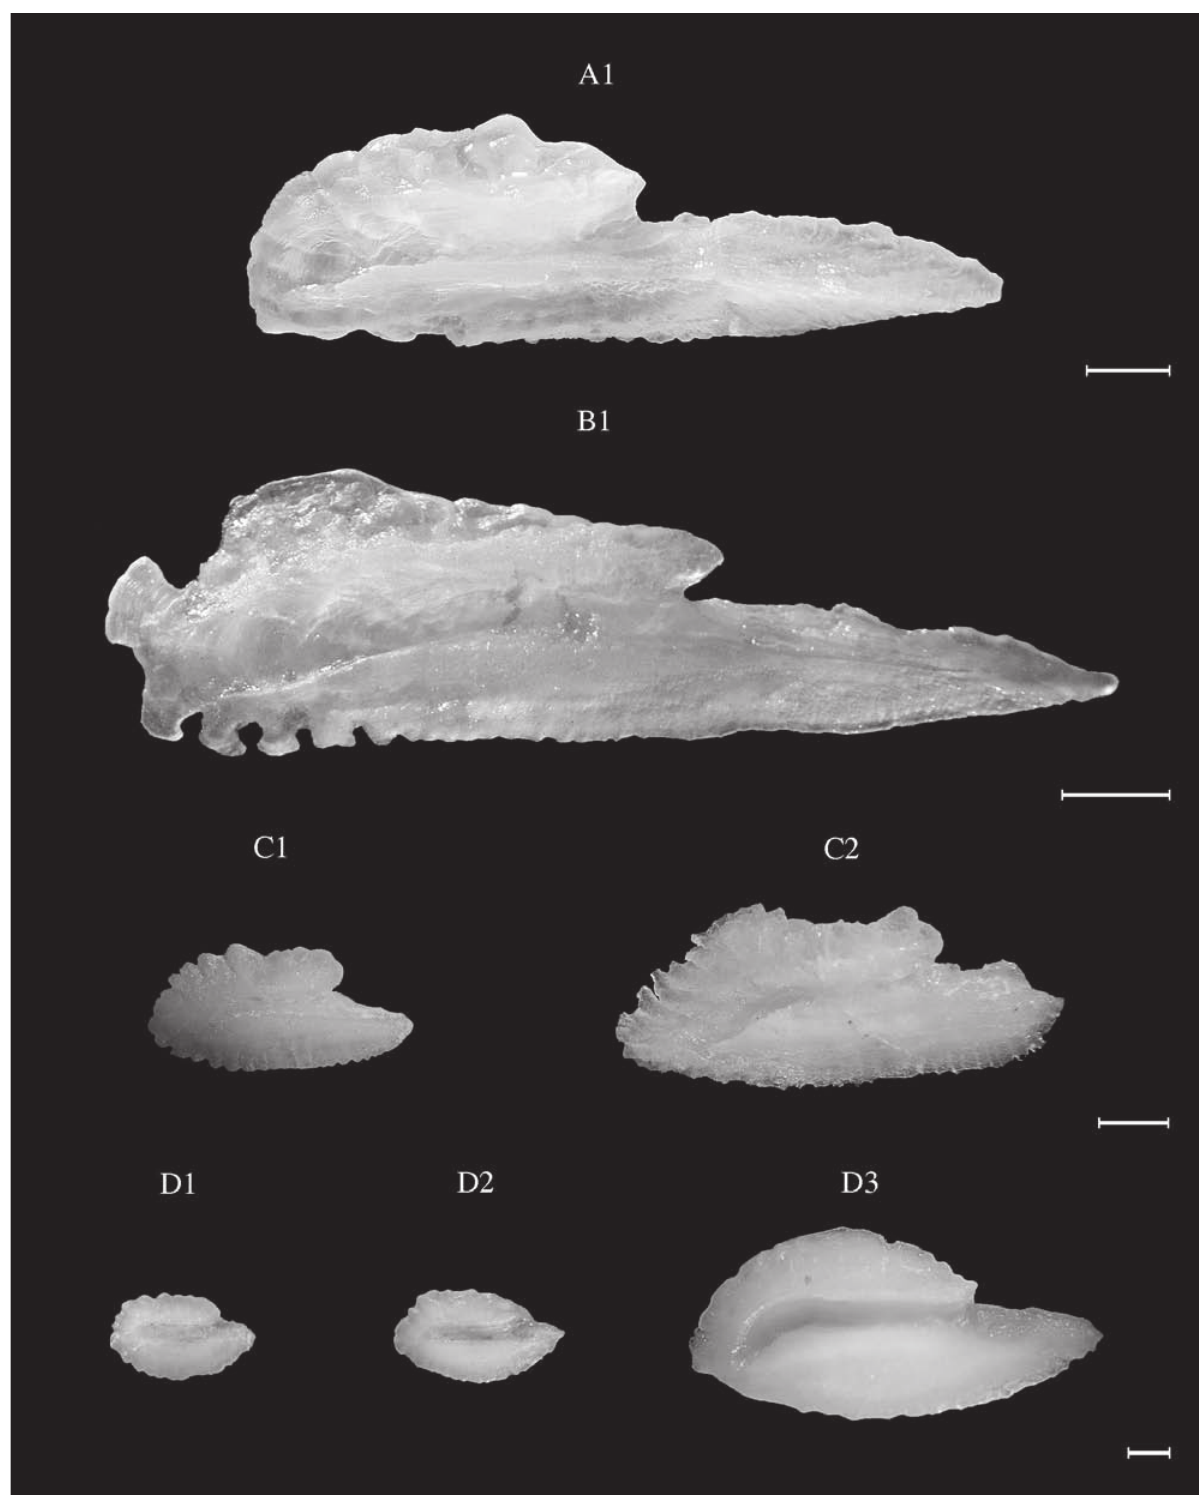
Fig. 53. – Seriola fasciata (CEA). TL: A1, 64.7 cm. Seriola rivoliana (CEA). TL: B1, 94.1 cm. Trachinotus ovatus (CEA). TL: C1, 19.5 cm; C2, 34.0 cm. Trachurus mediterraneus (WM). TL: D1, 11.5 cm; D2, 13.5 cm; D3, 36.0 cm. Scale bar = 1